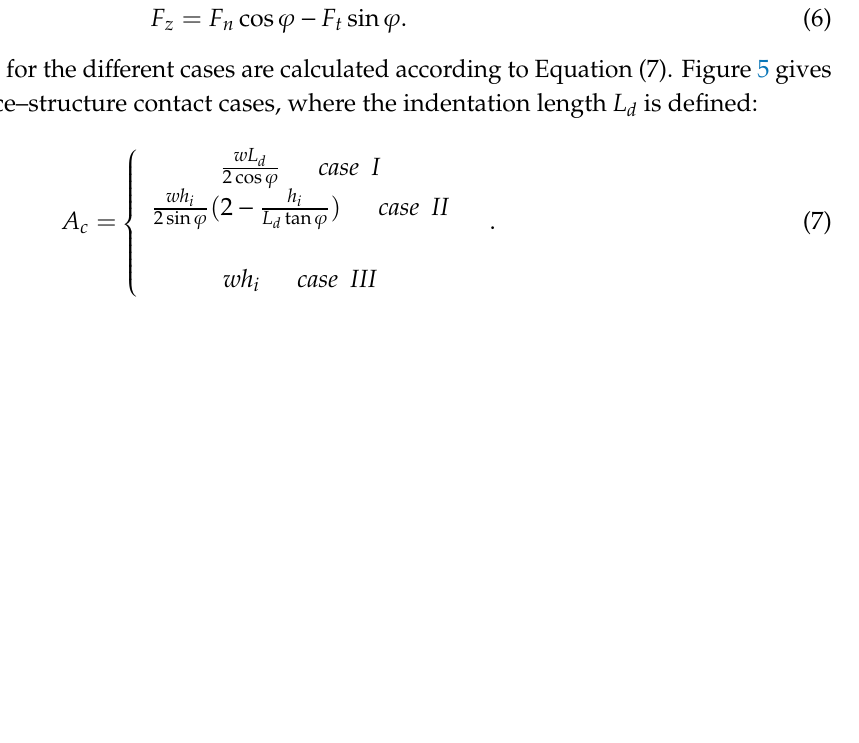
Figure 4. Ice – structure contact scenarios for the crushing process. Figure 4. Ice–structure contact scenarios for the crushing